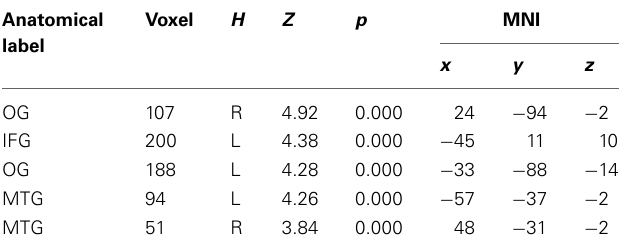
Table 4A | Interaction effects (conjunction of all offers).